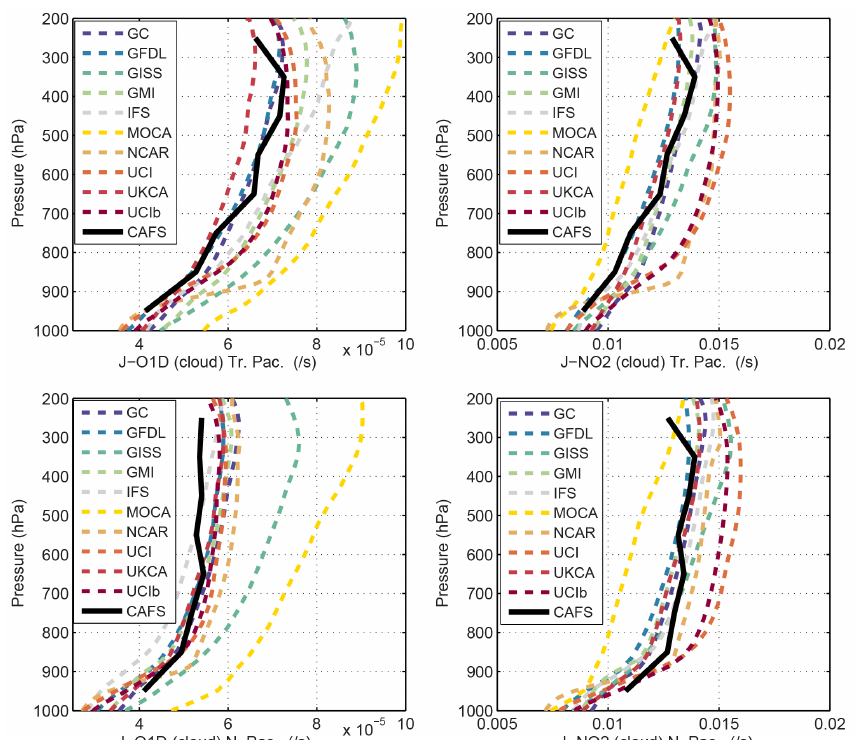
Figure 1. Profiles of all-sky (cloudy) J -O1D and J -NO2 for the tropical and North Pacific blocks. See Figs. S2 and S3. The CAFS values are directly measured in ATom-1. The 10 models are sampled over 24h from a day in mid-August, selecting for cos(SZA)>0.8. The UCI and UCIb models are distinct here because they treat overlapping clouds differently (cloud quadrature vs. B-averaged